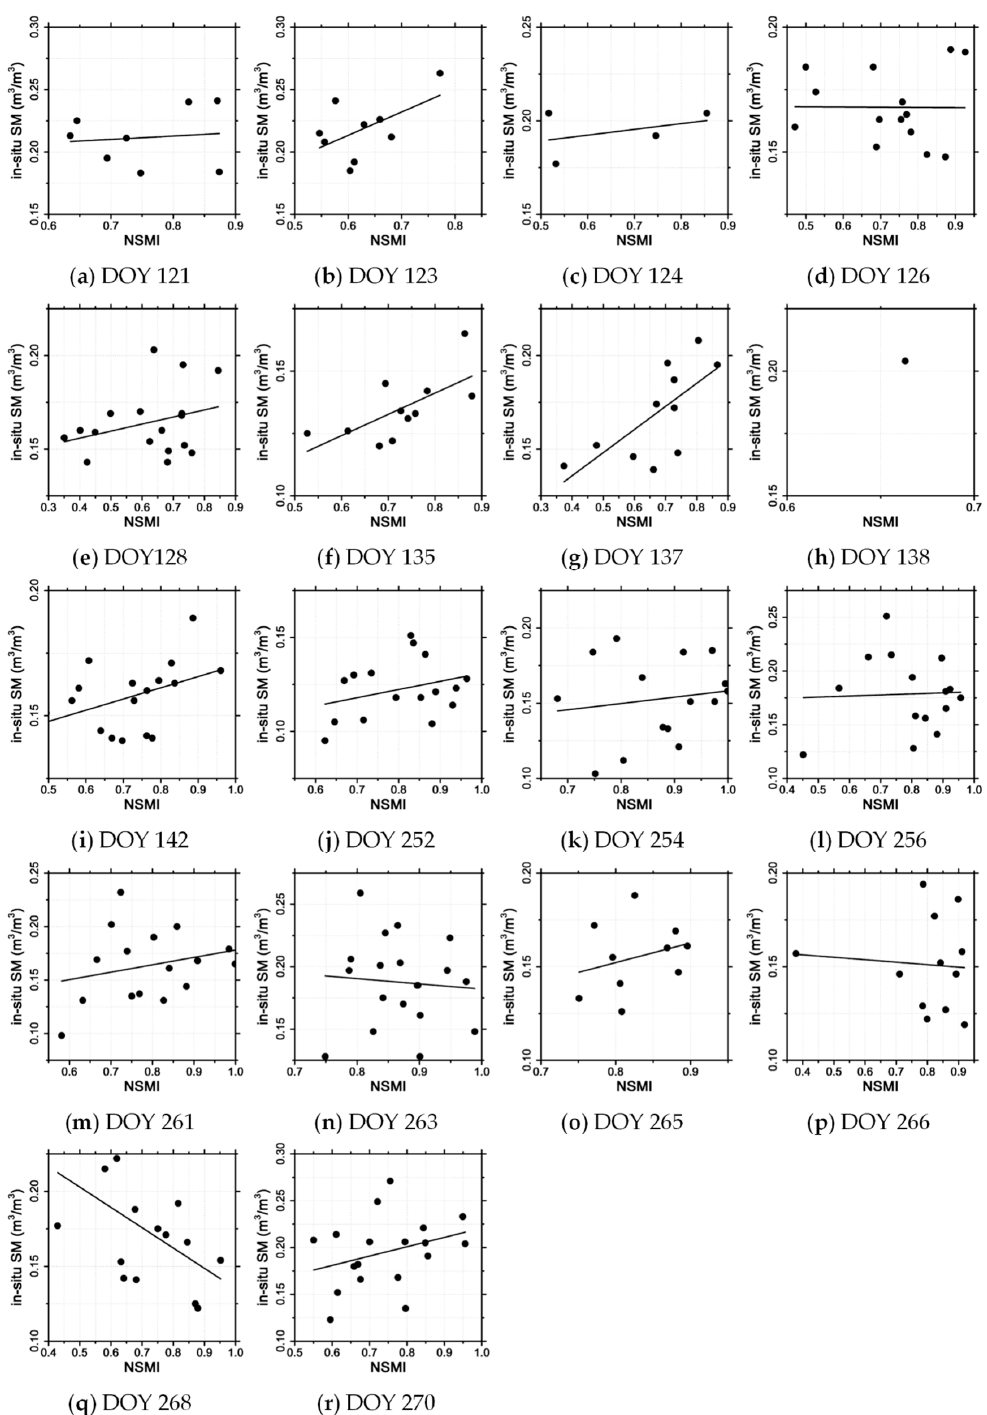
Figure 11. ( a – r ) Daily validation of the NSMI at 250 m resolution using in situ soil moisture measurements. The dashed line represents the linear fit line of in situ soil moisture related to the NSMI. Instead of the NRSD validation work, the NSMI was compared with in situ soil moisture at 10:30 a.m., which is synchronous with the MODIS Terra observation. Please note that the experiment on 16 September was excluded because all available in situ sites were within fully cloud-covered areas. Due to the cloud condition, also note that only one single in situ site was available on 18 May (DOY 138).